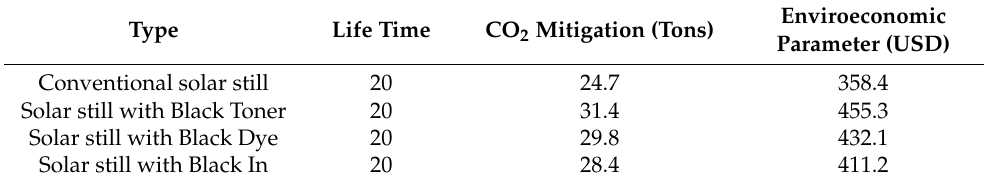
Table 7. CO 2 mitigation of different solar